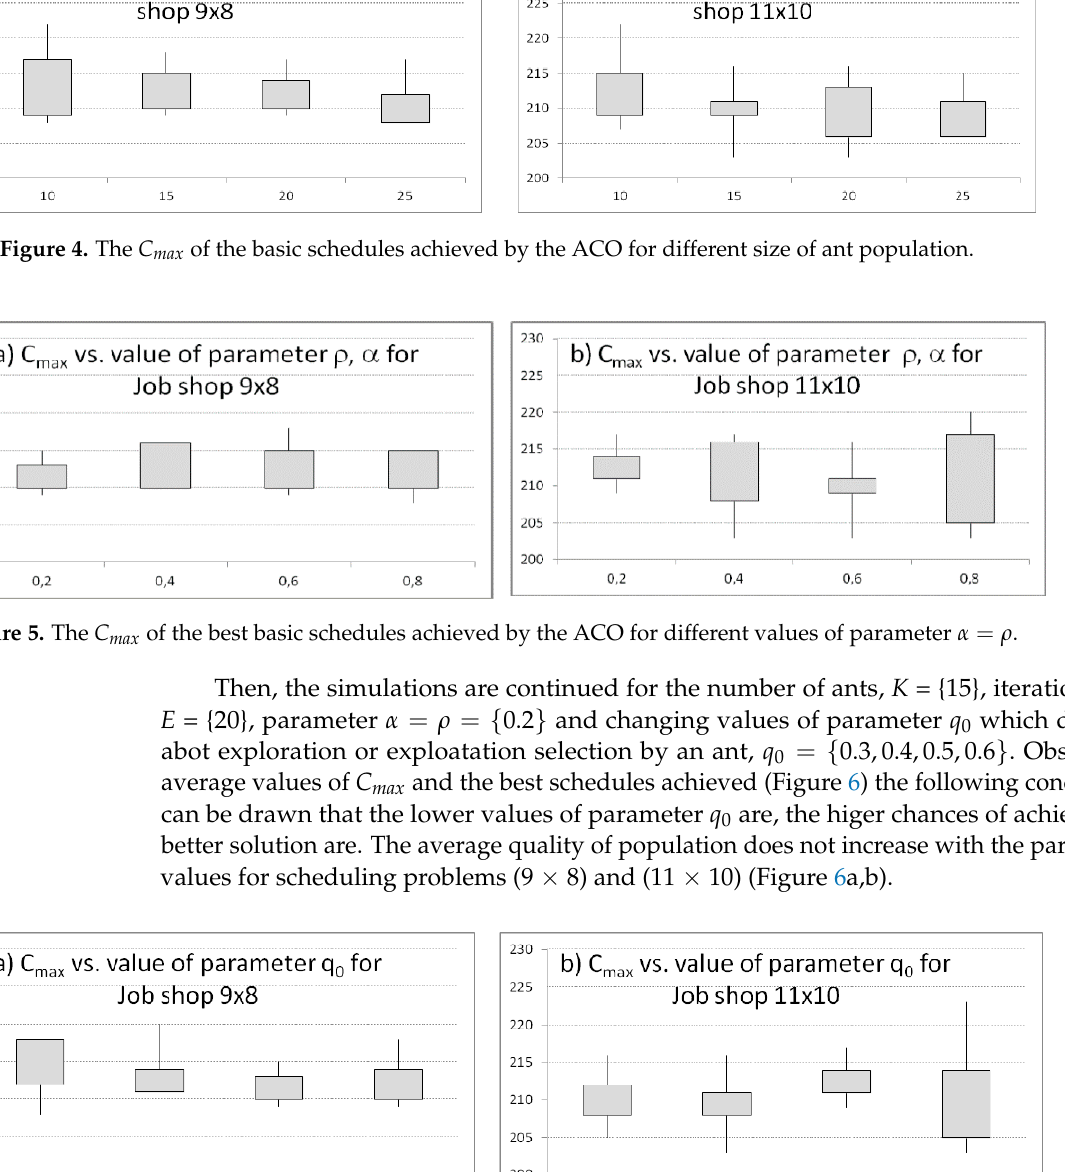
Figure 6. The C max of the basic schedules achieved by the ACO for different values of parameter q 0 .